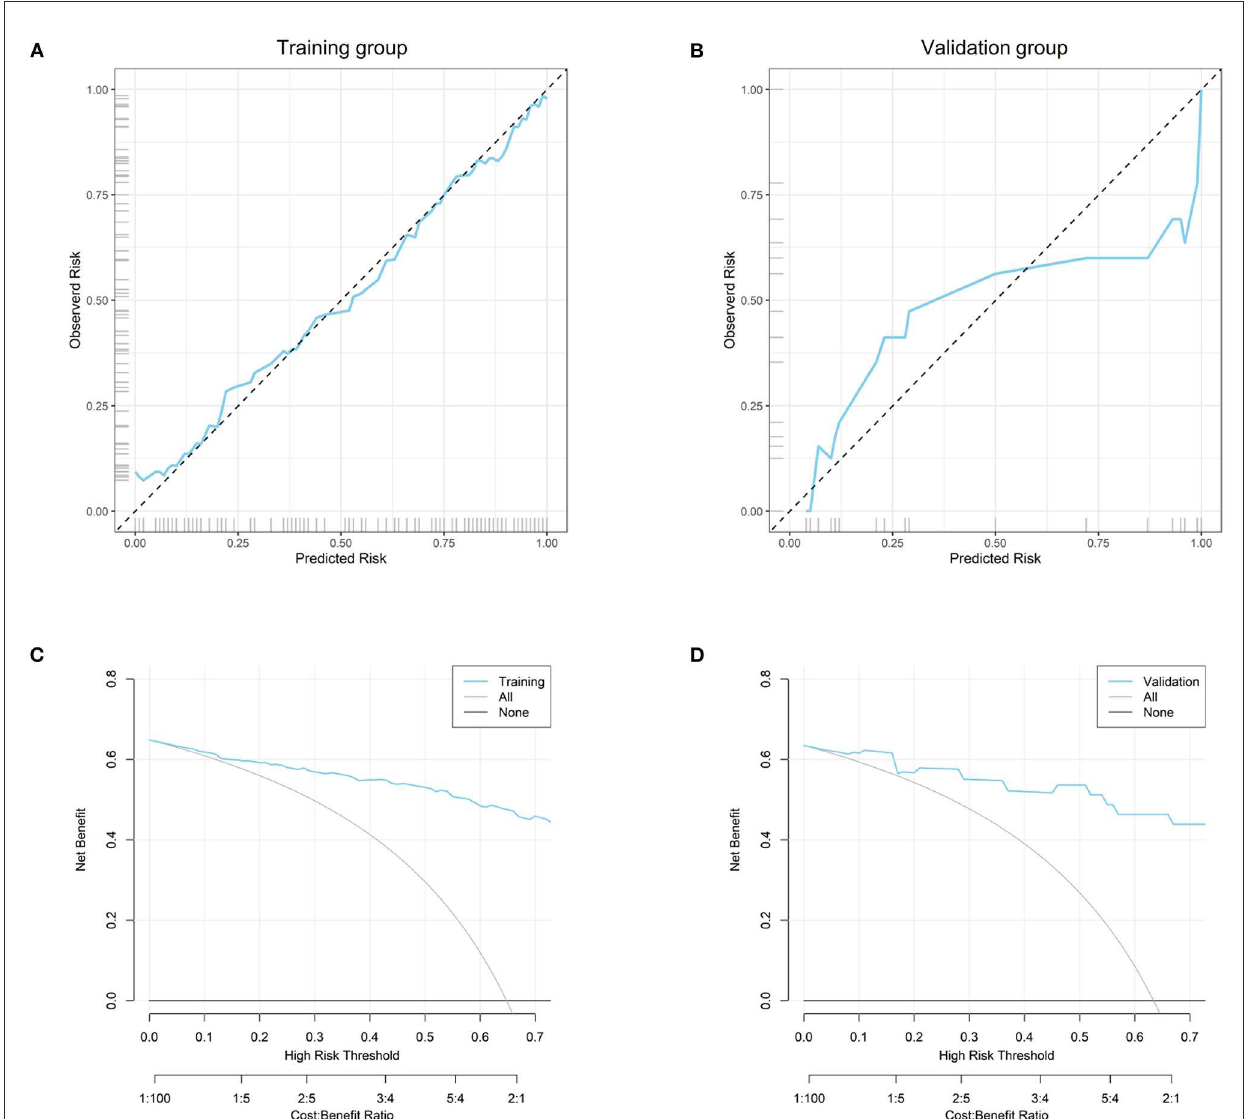
FIGURE5 Calibrating evaluation and clinical usefulness of the nomogram. (A) Calibration curve in the training group; (B) calibration curve in the validation group; (C) decision curve analysis in the training group; (D) decision curve analysis in the validation